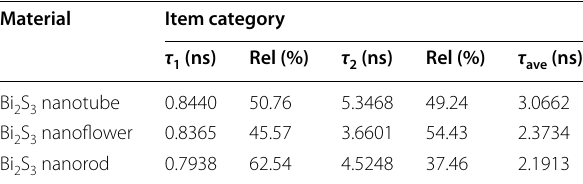
Table 2 The PL lifetime parameters of the Bi different